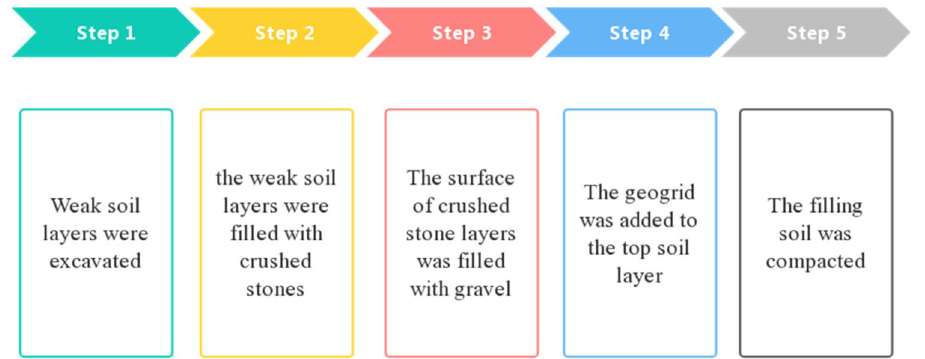
Figure 10. Steps of the replacement process.